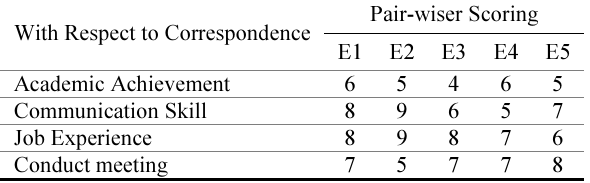
Table 4. Pair-wiser